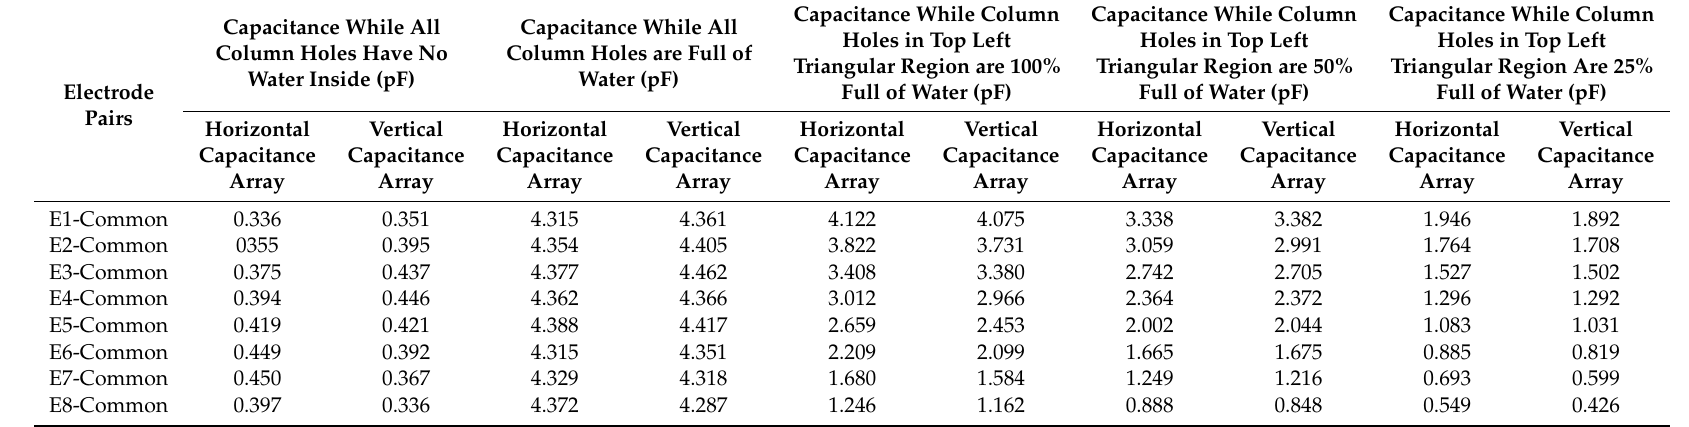
Table 3. The measured capacitances between di ff erent electrode pairs while one triangular region is full of di ff erent quantities of